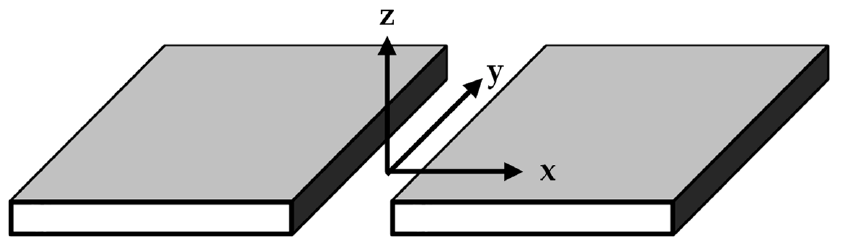
Figure 4. Simplified representation of two segments and coordinate axes in relation to their connection. (x-axis = perpendicular to the cut edge and tangential to the top surface; y-axis = located in the cut plane and tangential to the cut edge; z-axis = located in the cut plane and perpendicular to the top surface)